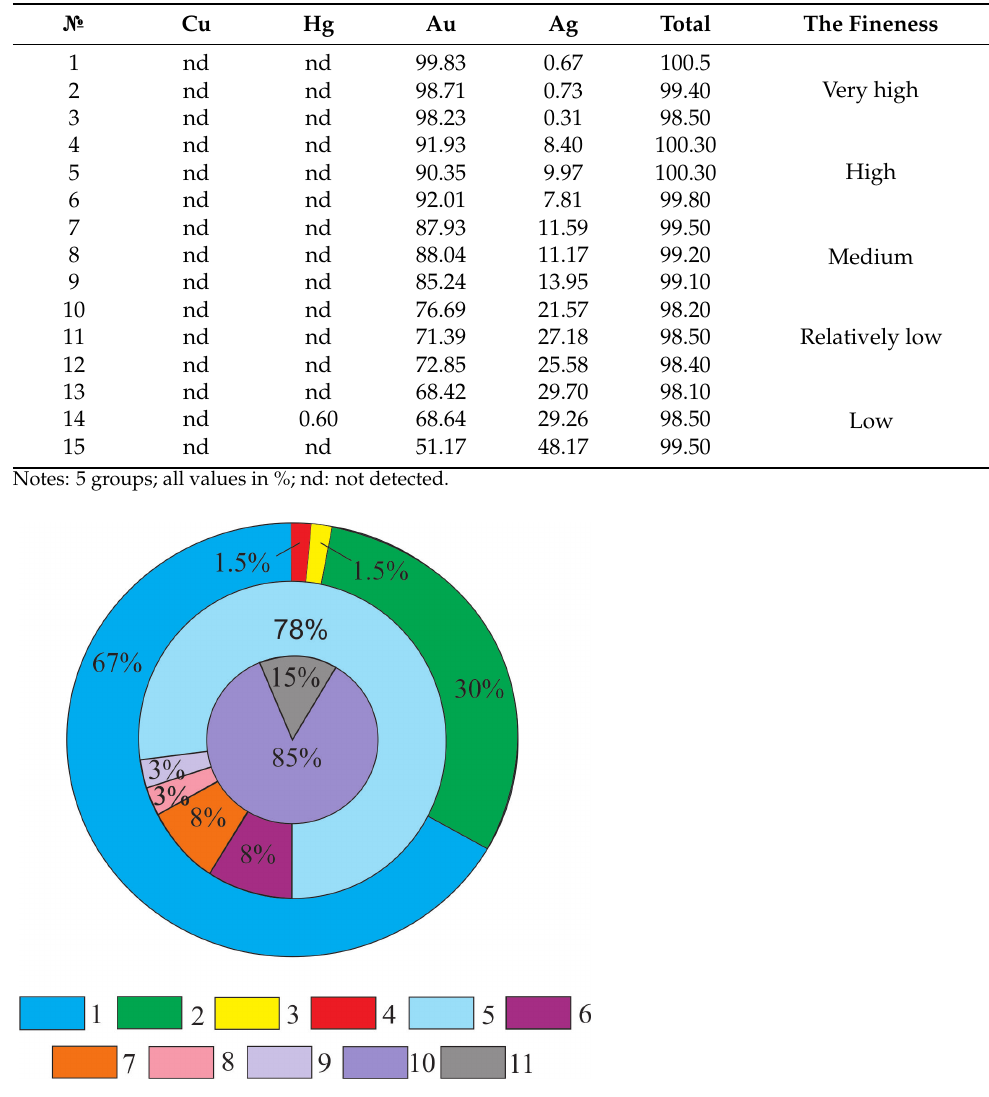
Table 1. The most typical analyses of the chemical composition of native gold of the Billyakh river placer on gradations of gold fineness.